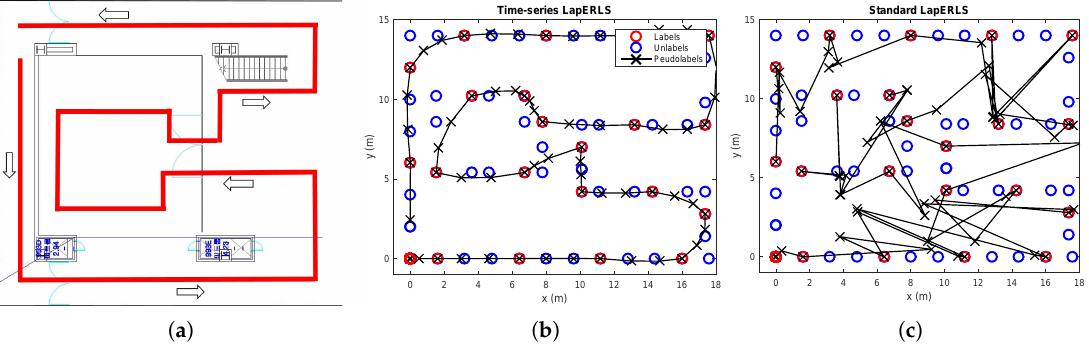
Figure 2. Comparison of accuracy of pseudolabels between time-series LapERLS (18) and standard LapERLS (12). The labeled, unlabeled, and pseudolabeled data points are marked by red circles, blue circles, and black crosses, respectively. ( a ) A user follows the red path and collects the labeled and unlabeled data. ( b ) The resultant pseudolabels from time-series LapERLS are so accurate that the trajectory made by the pseudolabels is close to the user’s true path. ( c ) Due to inaccurate pseudolabels obtained from the standard LapERLS, this trajectory is severely incorrect.